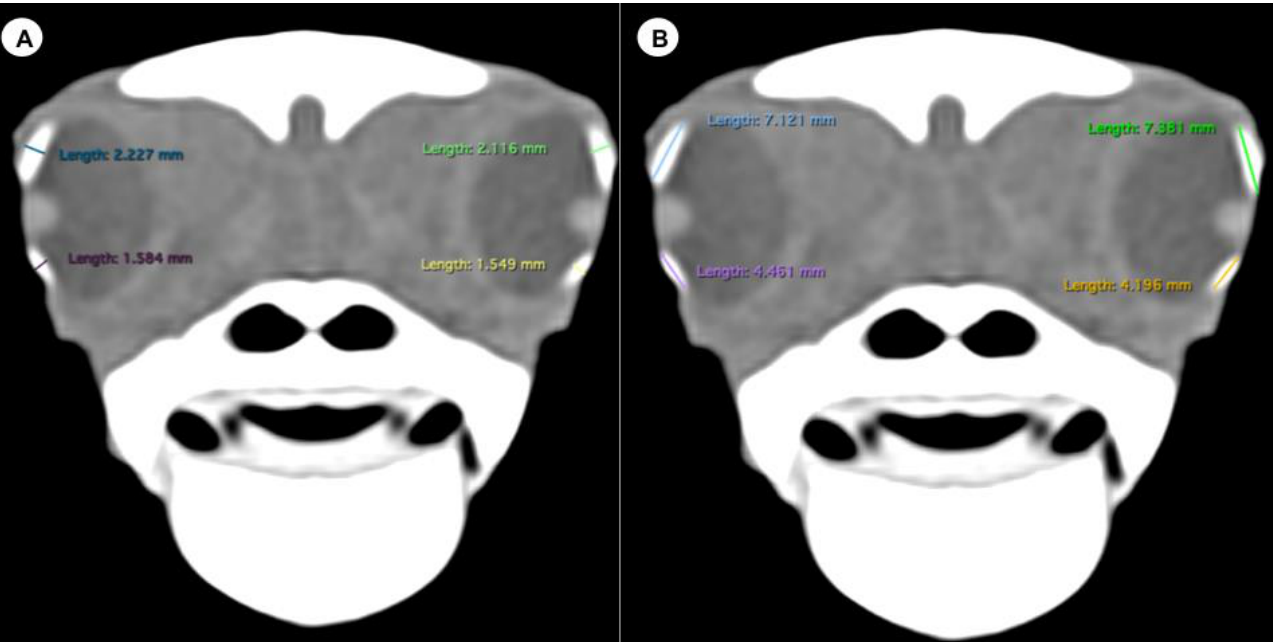
Figure 1. ( A ) Transverse multiplanar reconstruction ( MPR) related to the eyeball of the C. caretta with measurements of the lens and the internal and external diameters of the sclerotic ring. ( B ) Vol- ume rendering image of the C. caretta skull with the sclerotic ring (SR) and orbit (O). (B) Transverse plane concerning the turtle’s body - Dorsal and ventral arch length: the thickness of the upper and lower regions of the scleral ring, with the corneal and scleral margins (Figure 2B). - Width of the dorsal and ventral arches of the scleral ring, that is, of the upper and lower parts of the lateral portion of the ring (Figure 2).